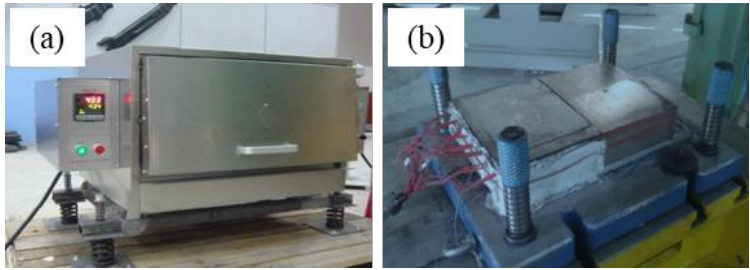
Figure 1. Quenching and heat treatment equipment: ( a ) heating furnace; ( b ) quenching mold.